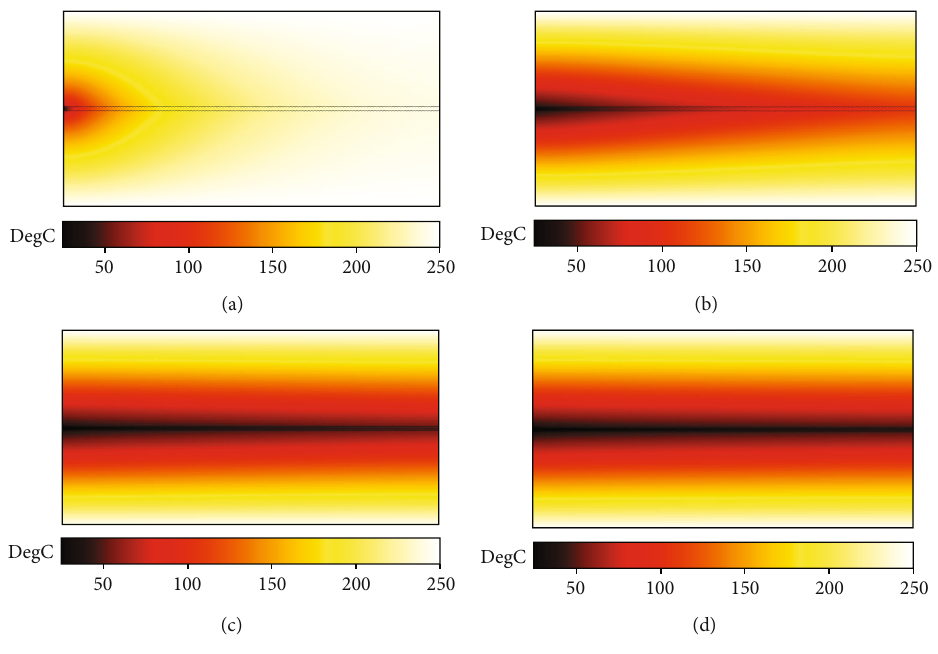
Figure 5: Temperature planar along